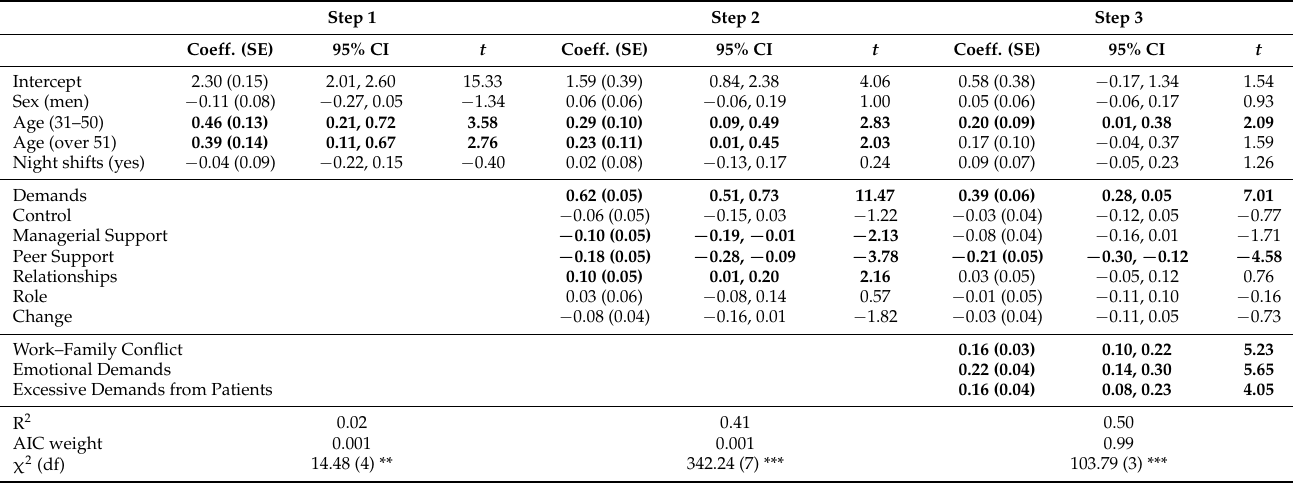
Table 2. Model comparison and parameter estimates for Emotional Exhaustion.